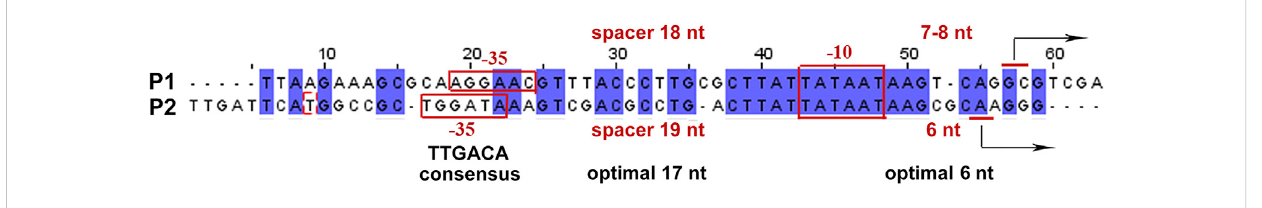
FIGURE 6 Alignment of sequences and comparison of regulatory elements in antisense (P1) and co-directed (P2) promoters located in the 3 ′ -terminal part of uxuR